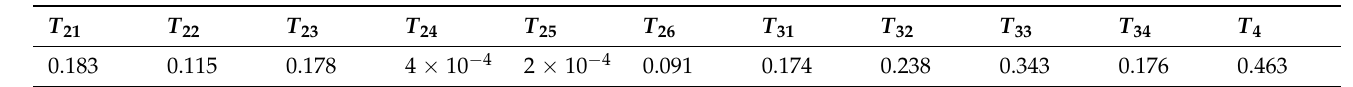
Table 7. Coupling values of each risk factor for construction accidents in the DFPs of adjacent existing underpass tunnels.